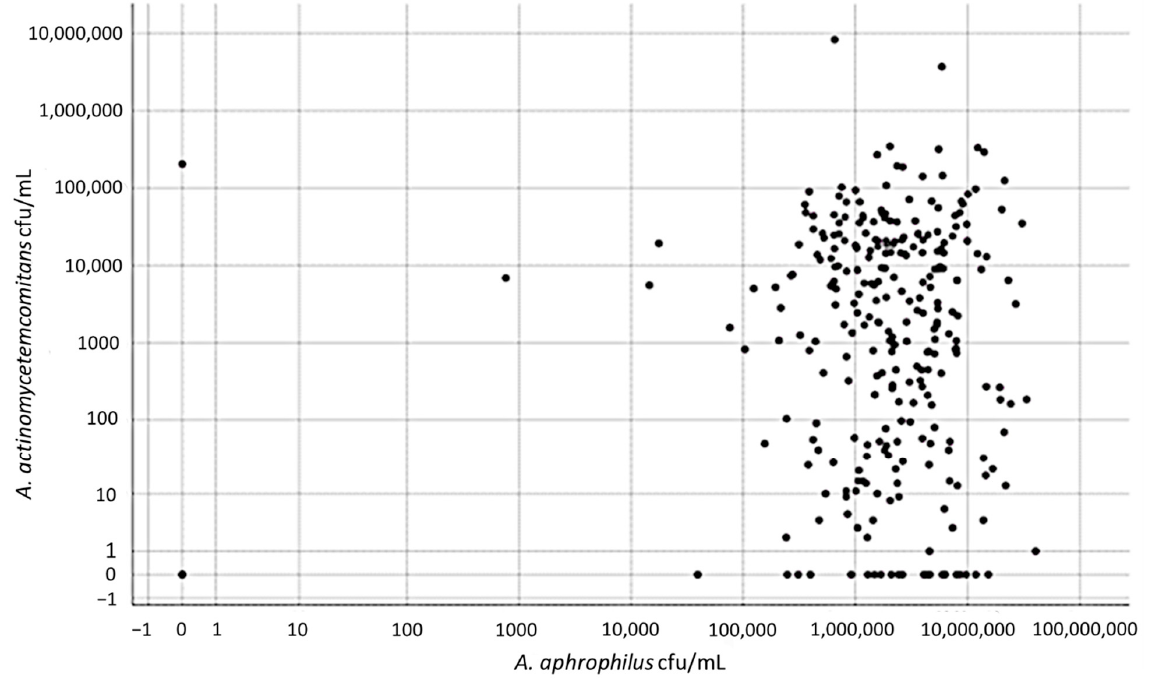
Figure 3. A comparison of the levels (cfu/mL) in saliva of A. actinomycetemcomitans and A. aphrophilus , respectively, as determined by qPCR. Samples from a total of 284 individuals of the Maasai Mara adolescent population were analyzed.